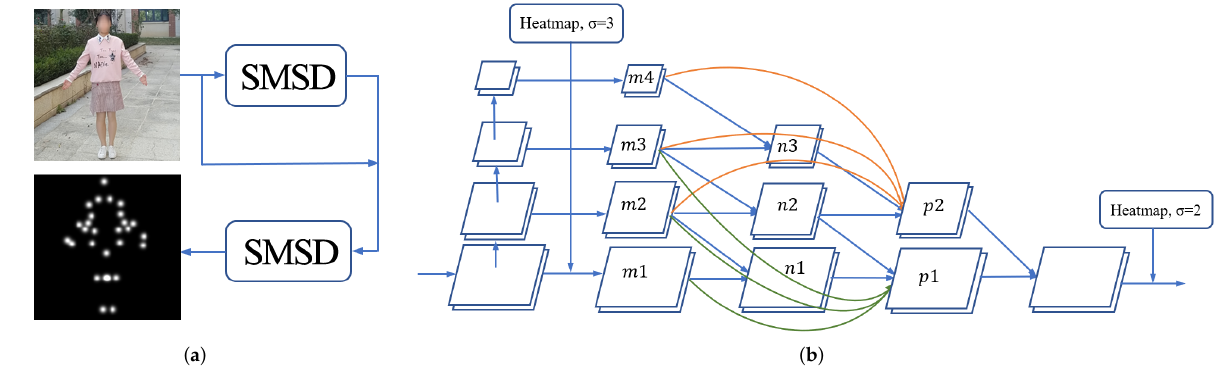
Figure 5. Our human body contour keypoint estimation network ( a ) and structure of SMSD block ( b ).